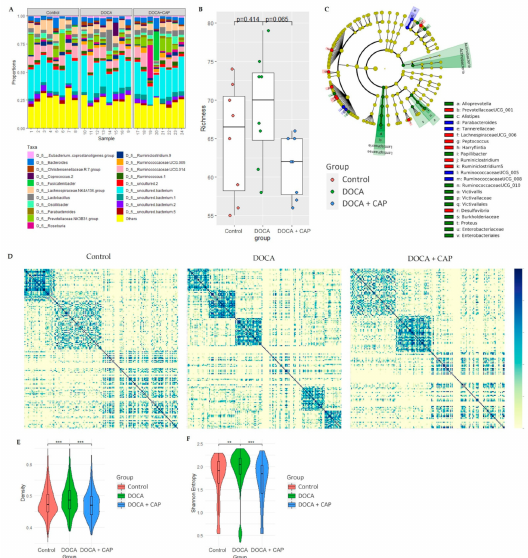
Figure 4. ( A ) Relative abundance TAXA plot of the top 20 most abundant genus-level taxonclassified sequences from gut bacterial 16S rRNA gene amplicon sequencing ( n = 24). ( B ) The gut